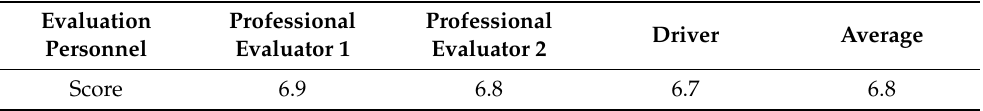
Table 3. Subjective evaluation scoring results